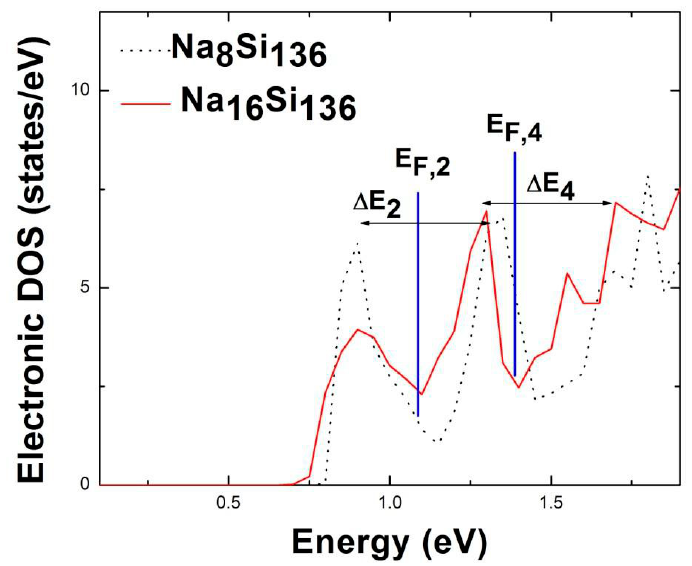
Figure 1. Illustration of the electronic density of states in the lower portion of the conduction band for clathrates Na 8 Si 136 and Na 16 Si 136. The Fermi energy levels ( E F,2 , E F,4 ) are marked by blue lines and quasi-activation energies ∆ E 2 , ∆ E 4 are given regarding sharply peaked structures.